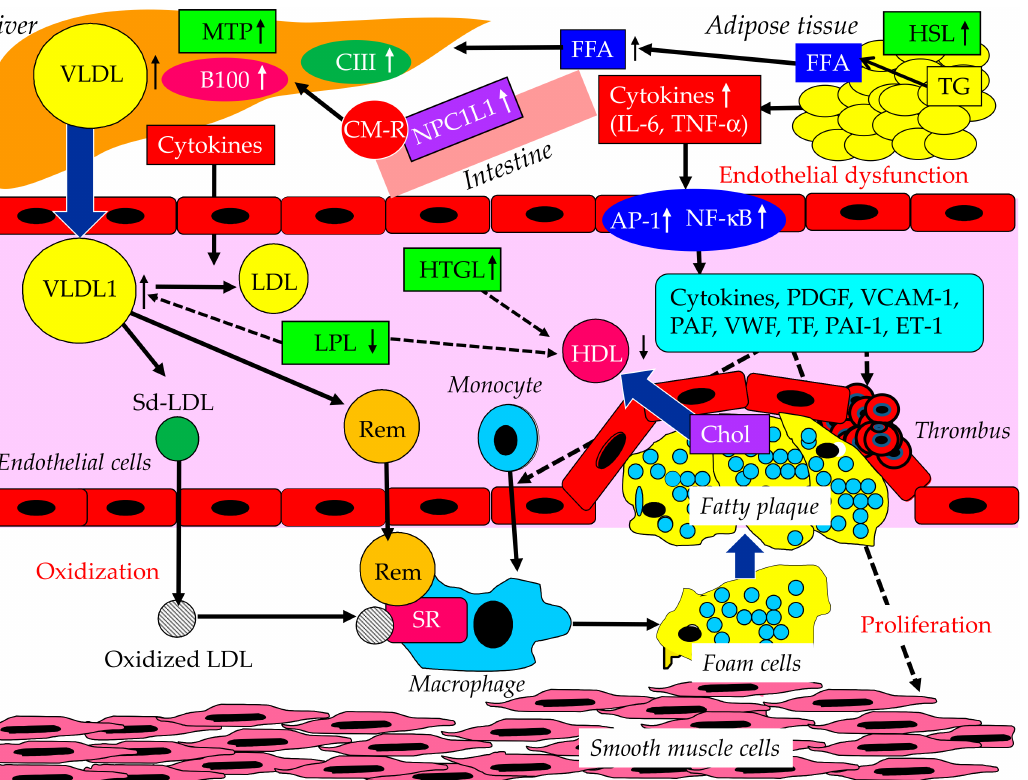
Figure 4. Molecular and biological mechanisms for the development of atherosclerosis by high TG and/or low HDL-C in insulin resistance. AP-1, activator protein 1; Chol, cholesterol; CM-R, chylomicron remnant; ET-1, endothelin-1; FFA, free fatty acid; HDL, high-density lipoprotein; HSL, hormone-sensitive lipase; HTGL, hepatic triglyceride lipase; LDL, low-density lipoprotein; LPL, lipoprotein lipase; MTP, microsomal triglyceride transfer protein; Sd-LDL, small dense LDL; NF- κ B, nuclear factor kappa B; NPC1L1,Niemann–Pick C1-Like 1; PAF, platelet-activating factor; PAI-1, plasminogen activator inhibitor-1; PDGF, platelet-derived growth factor; SR, scavenger receptor; Rem, remnant; TF, tissue factor; VCAM-1, vascular cell adhesion molecule-1; VLDL, very-low-density lipoprotein; VWF, von Willebrand